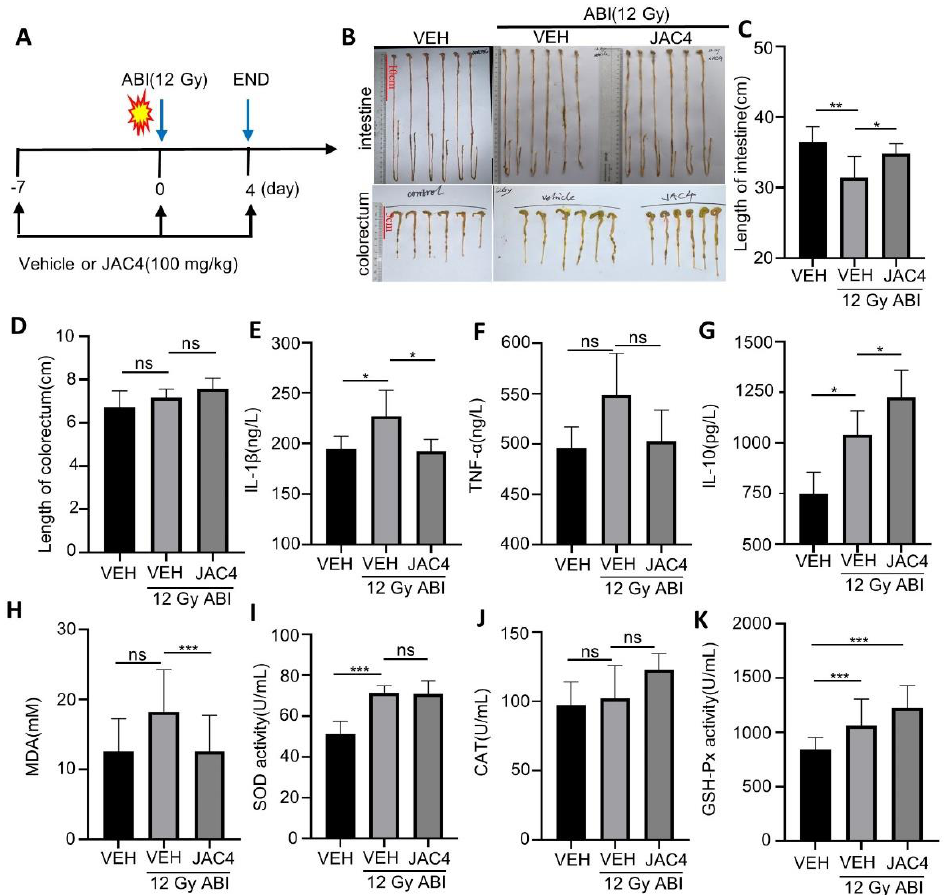
Figure 3. JAC4 inhibits X-ray-triggered inflammation and oxidative stress. ( A ) The schematic diagram of experimental design. C57BL/6 mice were pretreated with vehicle (VEH) or JAC4 for 7 days. Mice were then exposed to radiation (12 Gy). JAC4 treatment was continued for 4 days. Then, serum and small intestine tissues were collected. ( B ) Represented images of small intestine and colorectum; ( C , D ) quantitative statistics of small intestine and colorectum length; serum contents of IL-1 β ( E ), TNF- α ( F ), and IL-10 ( G ) were determined on the fourth day after ABI (n = 6); serum contents of MDA ( H ), SOD ( I ), CAT ( J ), and GSH-Px ( K ) were determined on day 4 after ABI (n = 6); the results are expressed as mean ± SEM (n = 6) (* p < 0.05; ** p < 0.01; *** p < 0.001; ns: p > 0.05). Given that the irradiation-triggered small intestine inflammation was due to oxida- tive stress events, we detected the anti-oxidant status of the intestine by the contents of the end product of lipid peroxidation malondialdehyde (MDA) and the activities of glu- tathione peroxidase (GSH-Px), superoxide dismutase (SOD), and catalase (CAT) in the serum of mice. As shown in Figure 3H, MDA contents were increased by ABI while obvi- ously being reduced by JAC4 in the mice. As a response to oxidative stress, ABI increased the activities of GSH-Px, CAT, and SOD; these anti-oxidative enzymes were further en- hanced by JAC4 treatment (Figure 3I – K). These data support that JAC4 inhibited small intestine inflammation and was associated with its anti-oxidant function.